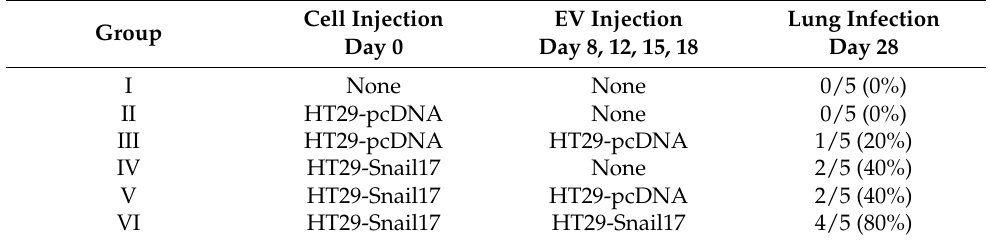
Table 1. Incidence of lung infection in mice with tumours inflicted by injection of control HT29- pcDNA or HT29-Snail cells followed by injections of various